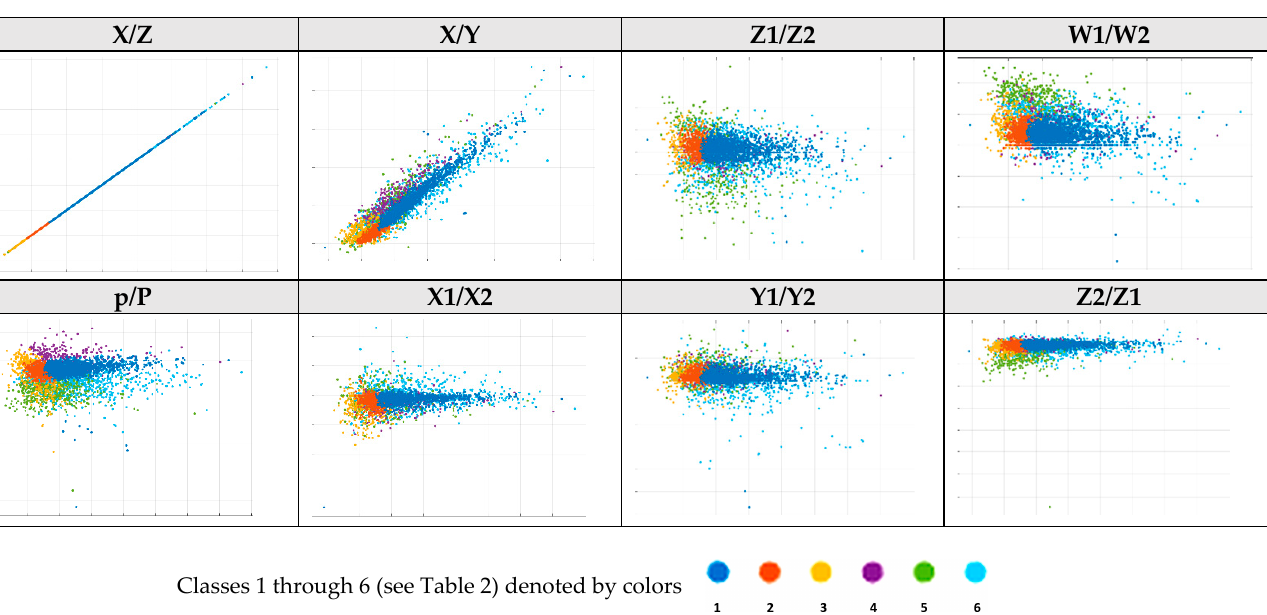
Table 4. Results of the classification of the main form data set.